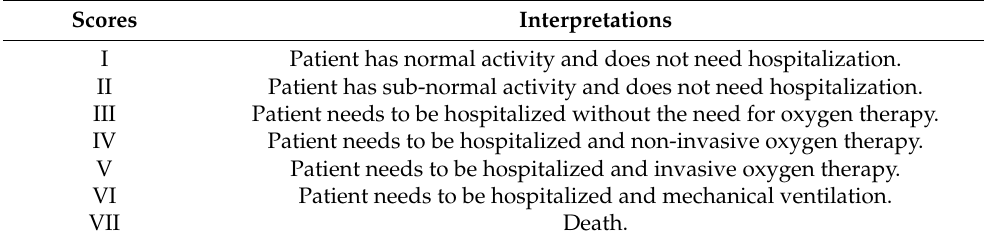
Table 7. Clinical scoring of COVID-19